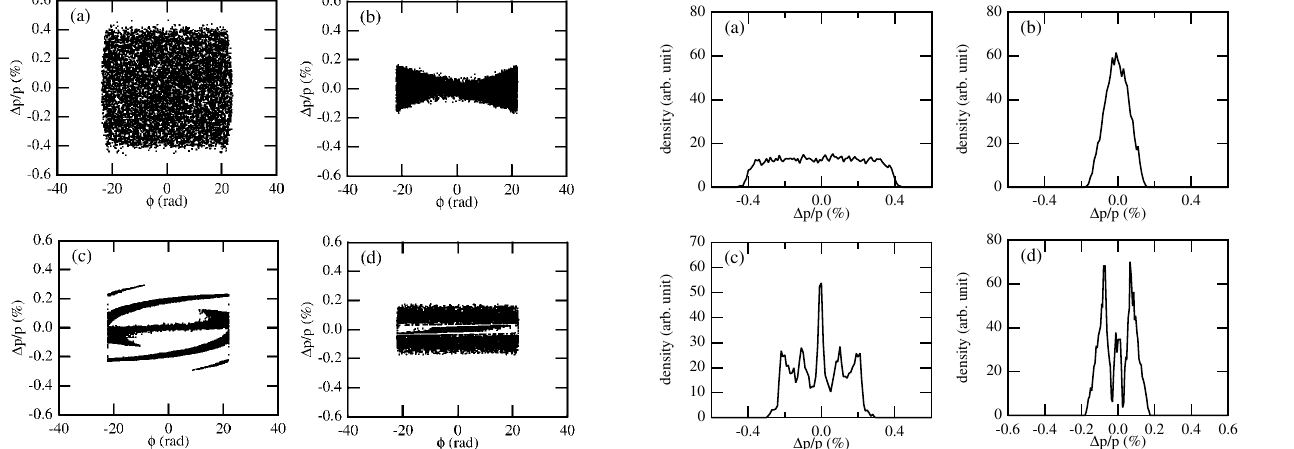
FIG. 7. Phase-space projection of a superbunch beam at (a) injection, (b) 4.69 GeV, (c) 6.69 GeV, and (d) 11.64 GeV. (cid:23) 7 (cid:14) (rad) and k (cid:4) (cid:5) 0 : 43 (cid:1) kV =(cid:22) s (cid:2) .